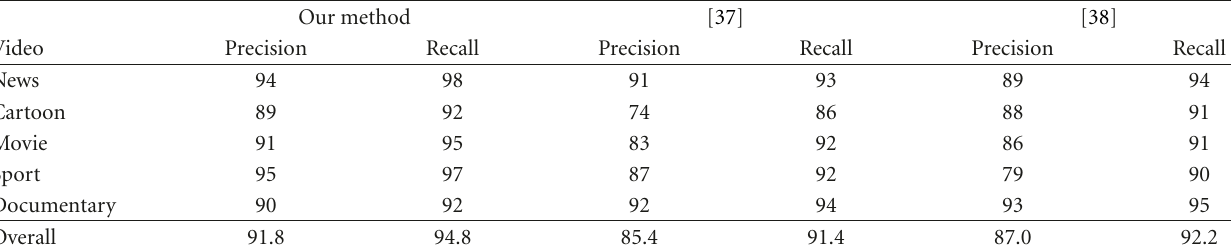
Table 2: Comparison of results of the di ff erent algorithms using our